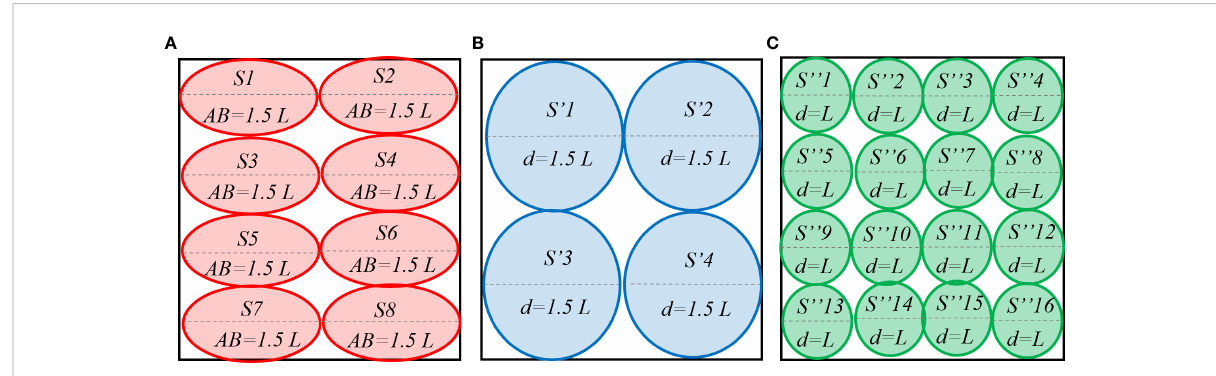
FIGURE 3 Schematic diagram of the in fl uence of (A) crossing, (B) overtaking, and (C) head-on scenarios features on generalization. S represents the state of the environment. AB is major axis of ellipse. d is the circle diameter. L indicates the length of the